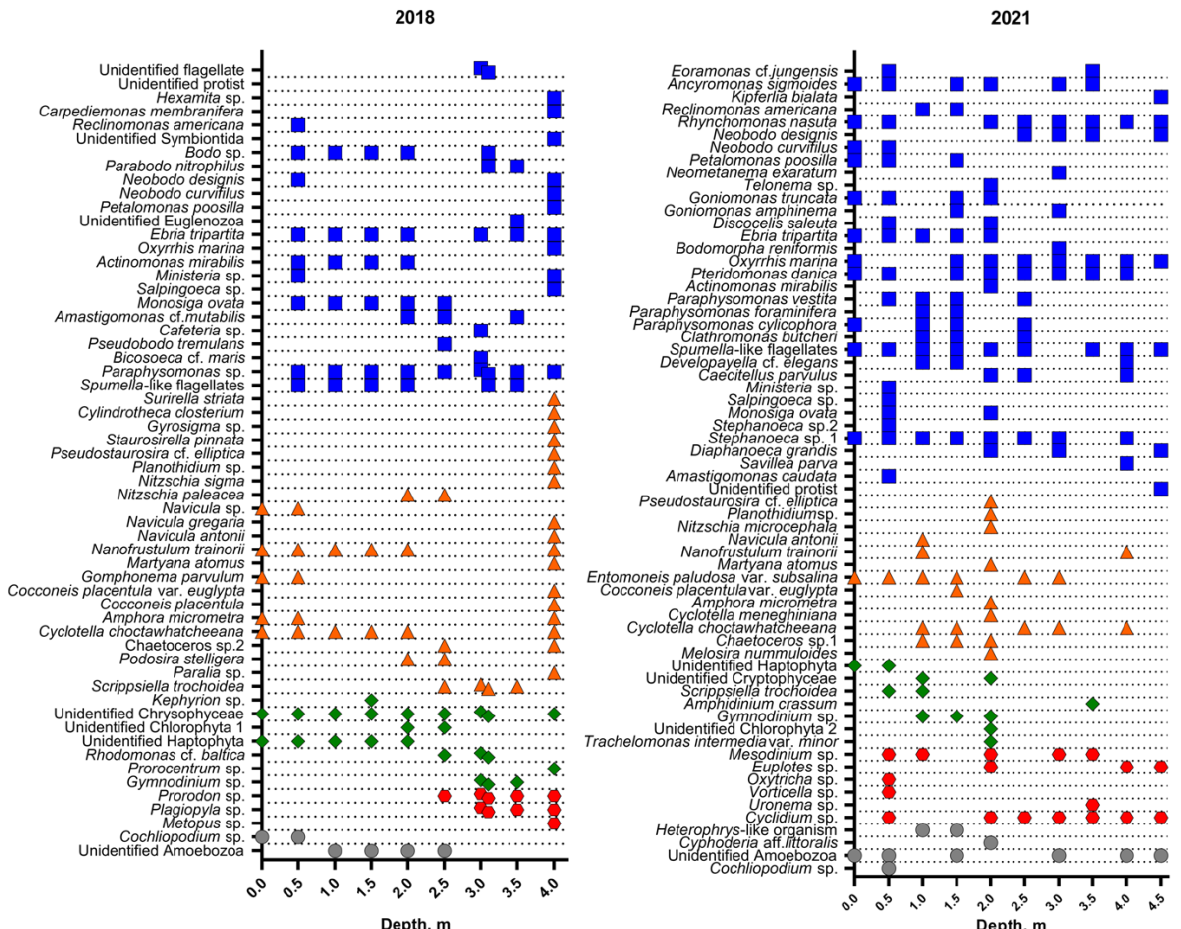
Figure 10. Vertical distribution in the water column of all protist species recorded in Lake Kislo-Sladkoe in 2018 and 2021. Blue squares — heterotrophic flagellates, orange triangles — diatoms, green diamonds — other phototrophic protists, red circles — ciliates, grey circles — amoebae and heliozoa.